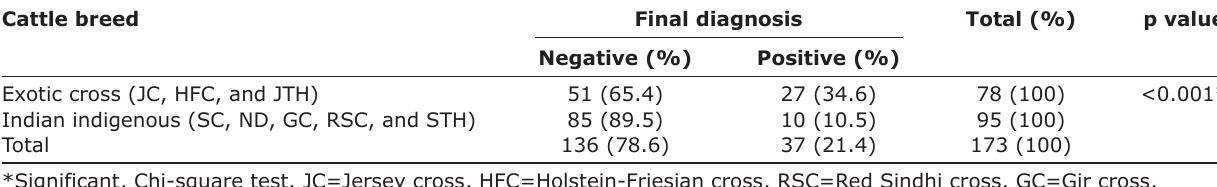
Table-3: Prevalence of bovine tuberculosis in different breeds of cattle in West Bengal. Cattle